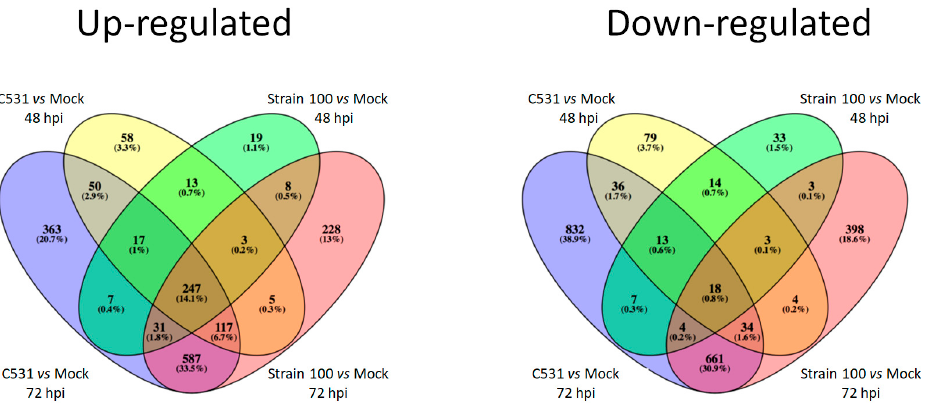
Figure 3. Venn diagram illustrating the comparison between down-regulated and up-regulated DEGs between BAT93 inoculated plants (Strain 100, compatible interaction, and C531, incompatible interaction) vs. Mock at 48 hpi and 72 hpi.